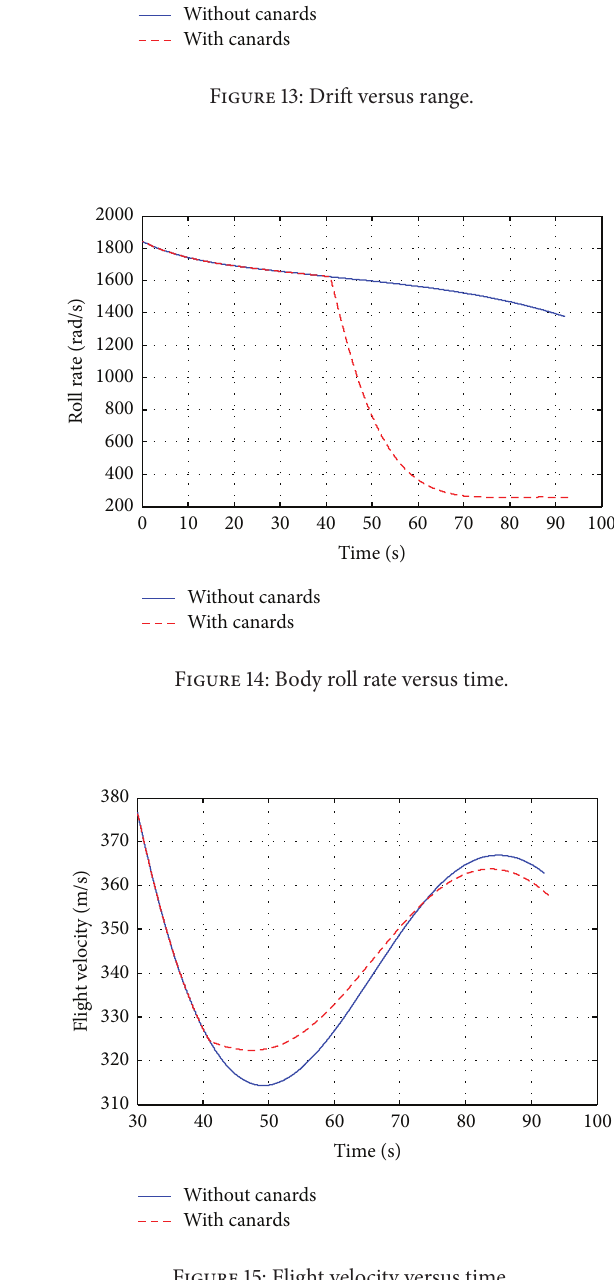
Figure 15: Flight velocity versus